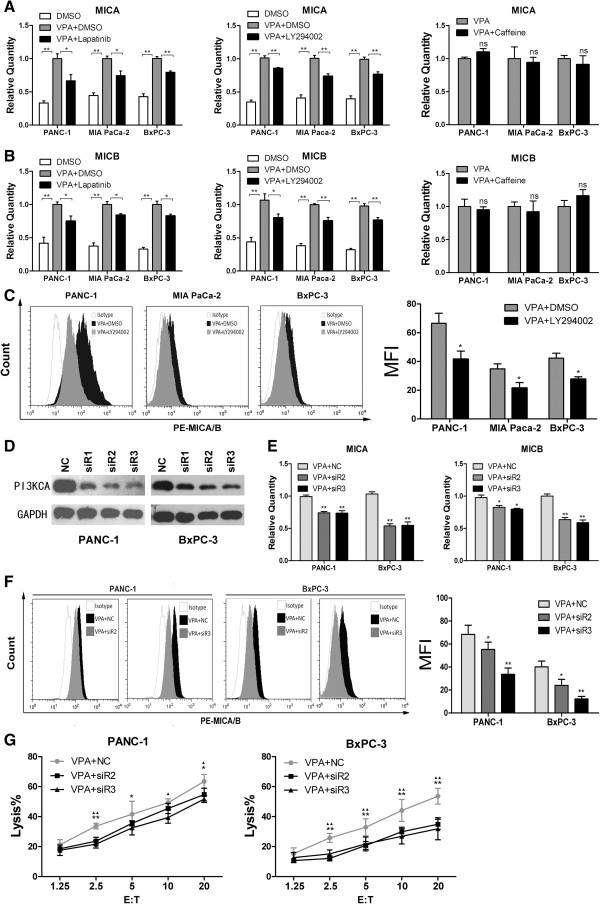
PI3K/Akt signaling is required for VPA-induced upregulation of MICA and MICB in pancreatic cancer cells. (A, B) Quantitative real-time RT-PCR analysis. The VPA-induced upregulation of MICA and MICB mRNA expression were inhibited by the HER2/HER3 inhibitor lapatinib and the PI3K inhibitor LY294002, but not by the ATM/ATR inhibitor caffeine. Data are mean ± SD of a single experiment performed in triplicate, all results were reproducible in three independent experiments. * P < 0.05; ** P < 0.01; ns P > 0.05. (C) Flow cytometry analysis. The VPA-induced upregulation of MICA and MICB protein expression on the cell surface were inhibited by the PI3K inhibitor LY294002. MFI, mean fluorescence intensity; * P < 0.05. (D) Western blotting analysis. Transfection of the PI3KCA siRNA inhibited PI3KCA protein expression at 48 h post-transfection. NC, negative control; siR1-3, PI3KCA_siR sequence 1-3; ** P < 0.01. (E) Quantitative real-time RT-PCR analysis. VPA-induced upregulation of MICA and MICB mRNA expression were attenuated in PI3KCA-knockdown cells; Data are mean ± SD of a single experiment performed in triplicate, all results were reproducible in three independent experiments. ** P < 0.01. (F) Flow cytometric analysis. VPA-induced upregulation of MICA and MICB protein expression on the cell surface were attenuated in PI3KCA-knockdown cells. MFI, mean fluorescence intensity; * P < 0.05; ** P < 0.01. (G) LDH release assay. The VPA-induced susceptibility of cancer cells to NK cell-mediated cell lysis was reduced in PI3KCA-knockdown cells. Data are mean ± SD of a single experiment performed in triplicate, all results were reproducible in three independent experiments. ** P < 0.01 and * P < 0.05 for NC vs. siR2; ▲▲ P < 0.01 and ▲ P < 0.05 for NC vs. siR3. siR2, PI3KCA siR sequence 2; siR3, PI3KCA siR sequence 3.